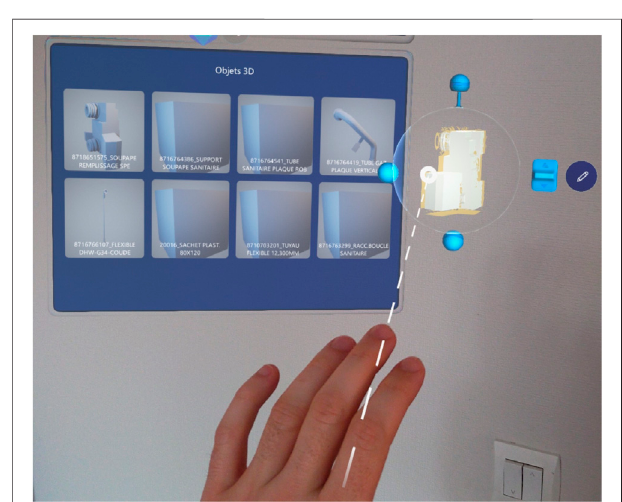
Frontiers in Virtual Reality |